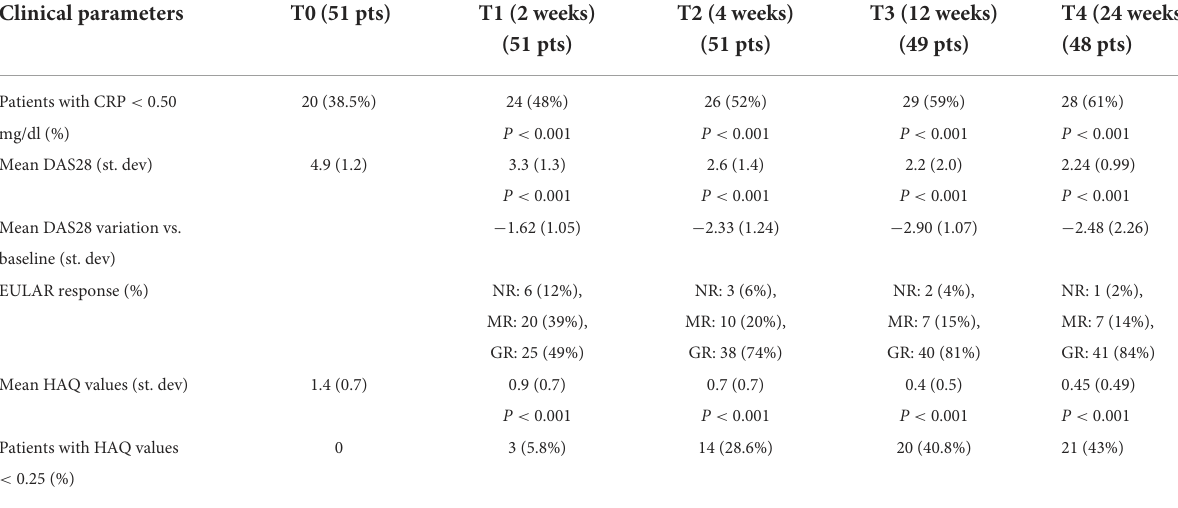
TABLE 2 Variation of clinical and laboratory parameters during treatment. Clinical parameters